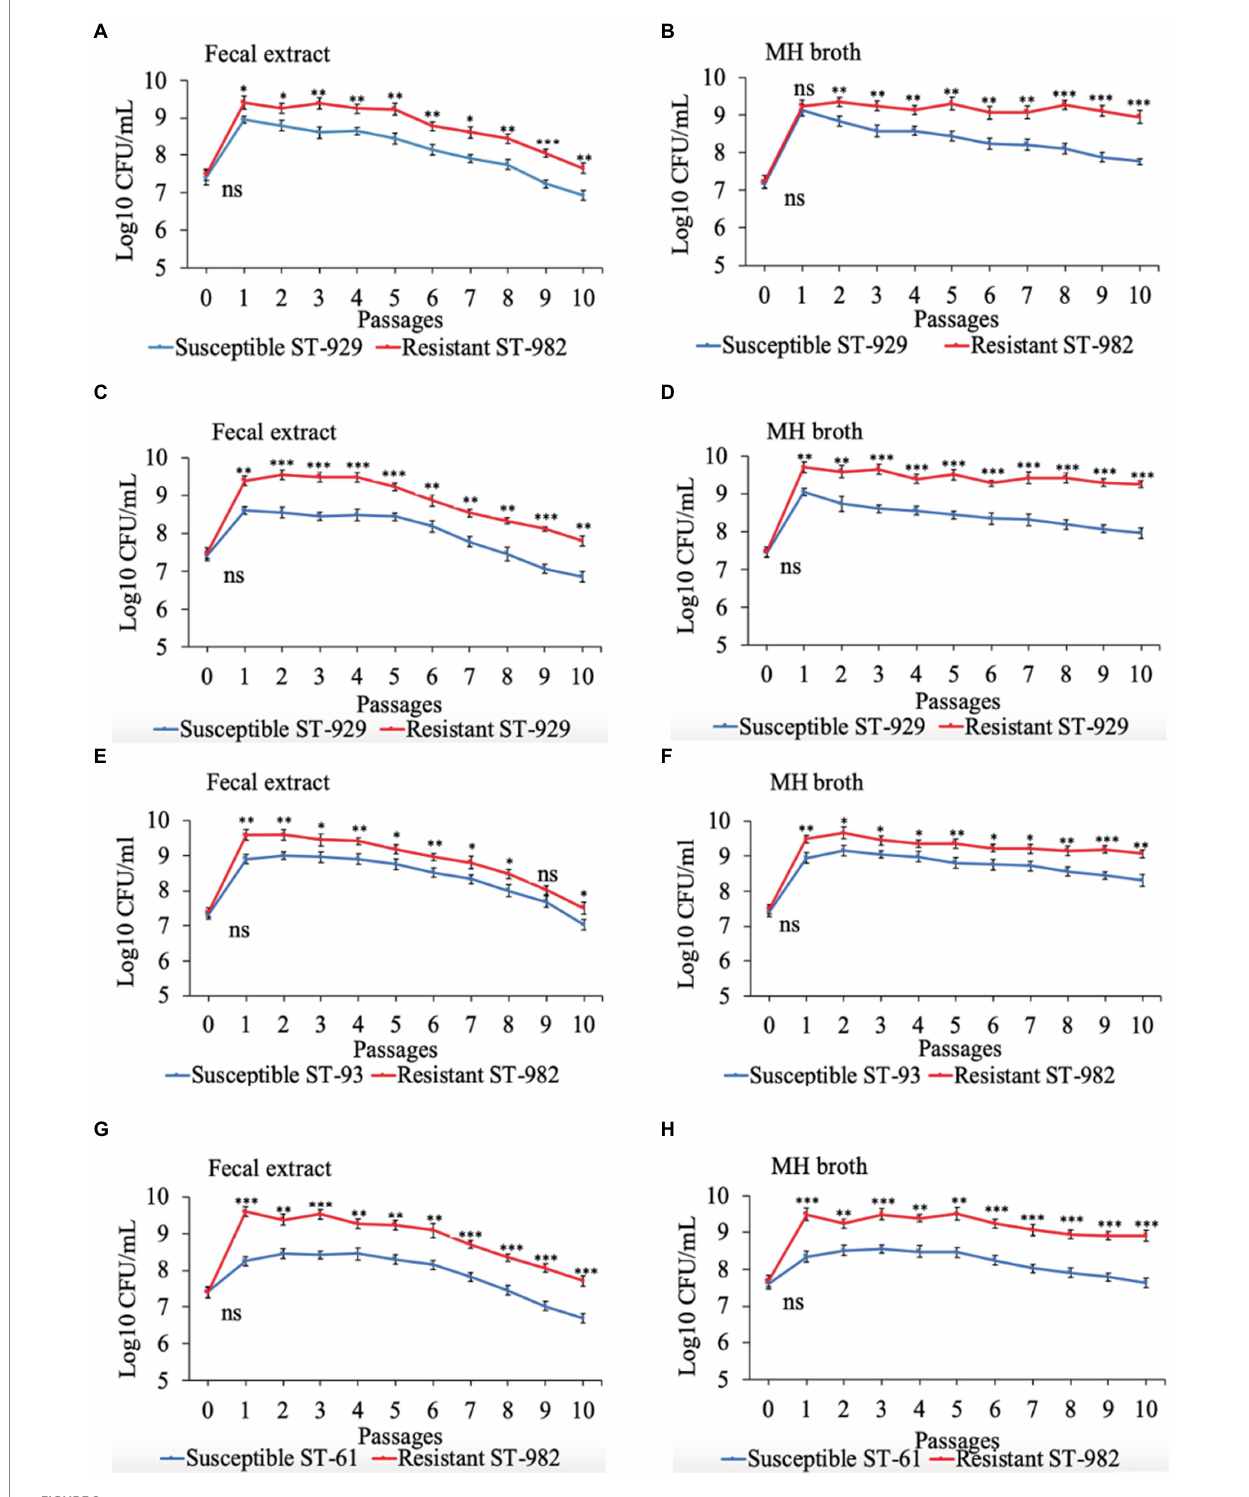
FIGURE 2 Growth kinetics of FQ-resistant Campylobacter jejuni (shown as red lines; resistant ST-982 and resistant ST-929) and FQ-susceptible C. jejuni (shown as blue lines; susceptible ST-929, susceptible ST-93, and susceptible ST-61) strains of various genetic background as determined by pairwise competition experiments in mixed culture in bovine fecal extract (A,C,E,G) and MH broth (B,D,F,H) . The initial bacterial cell density was 10 7 CFU/mL for each strain. The CFU of each strain at the baseline of each passage was calculated (24 h interval). Significant differences between resistant and susceptible strains are indicated by asterisks: p -values less or equal to 0.001 are summarized with three asterisks, p -values less or equal to 0.01 are summarized with two asterisks, and p -values less or equal to 0.05 are summarized with one asterisk. The experiment was repeated twice, and the results of one representative experiment are